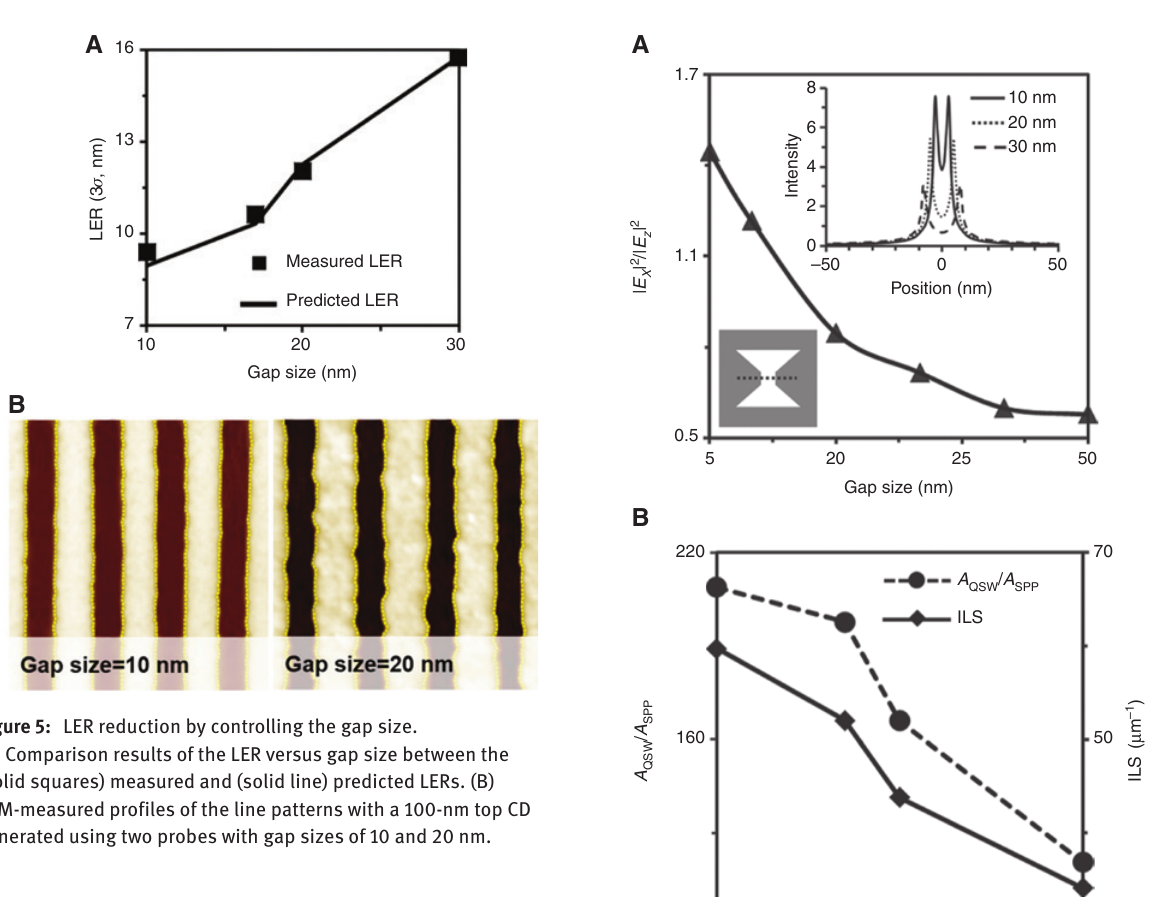
cross-sectional view of the intensity distribution (at the center of the ridge aperture along the x -direction on the PR surface) is shown in the inset of Figure 6A.